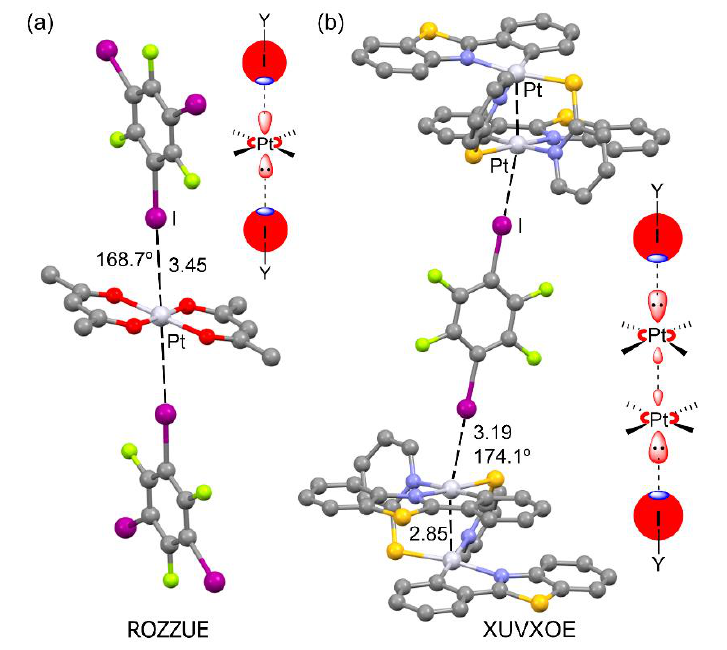
Figure 1. X-ray structures of ROZZUE ( a ) and XUVXOE ( b ). H-atoms omitted. Distances are given in Å . Color code: Carbon grey, fluorine light green, platinum light grey, sulfur yellow, iodine pur-